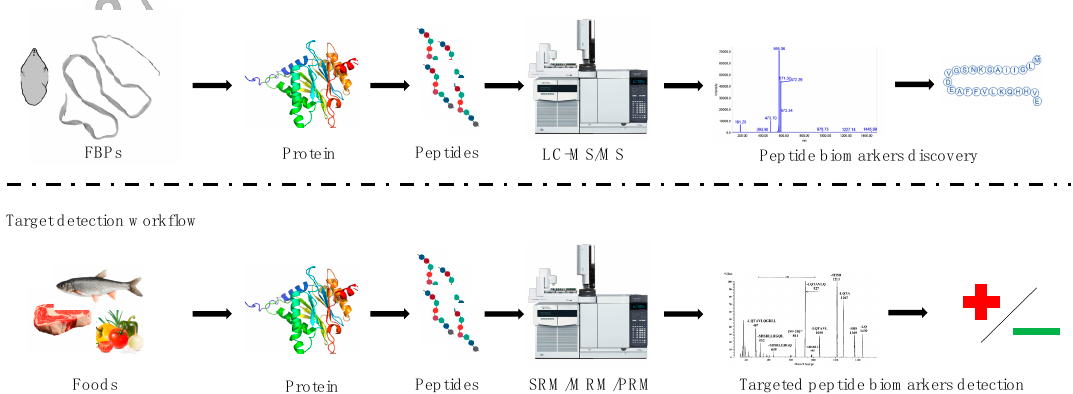
Figure 1. Schematic representation of two proteomic strategies in the studies of foodborne parasites (FBPs): discovery and targeted workflows. Red plus—positive detection (sample contaminated); green minus—negative detection (sample free); LC-MS/MS—liquid chromatography tandem mass spectrometry; SRM/MRM/PRM—selected/multiple/parallel—reaction monitoring.